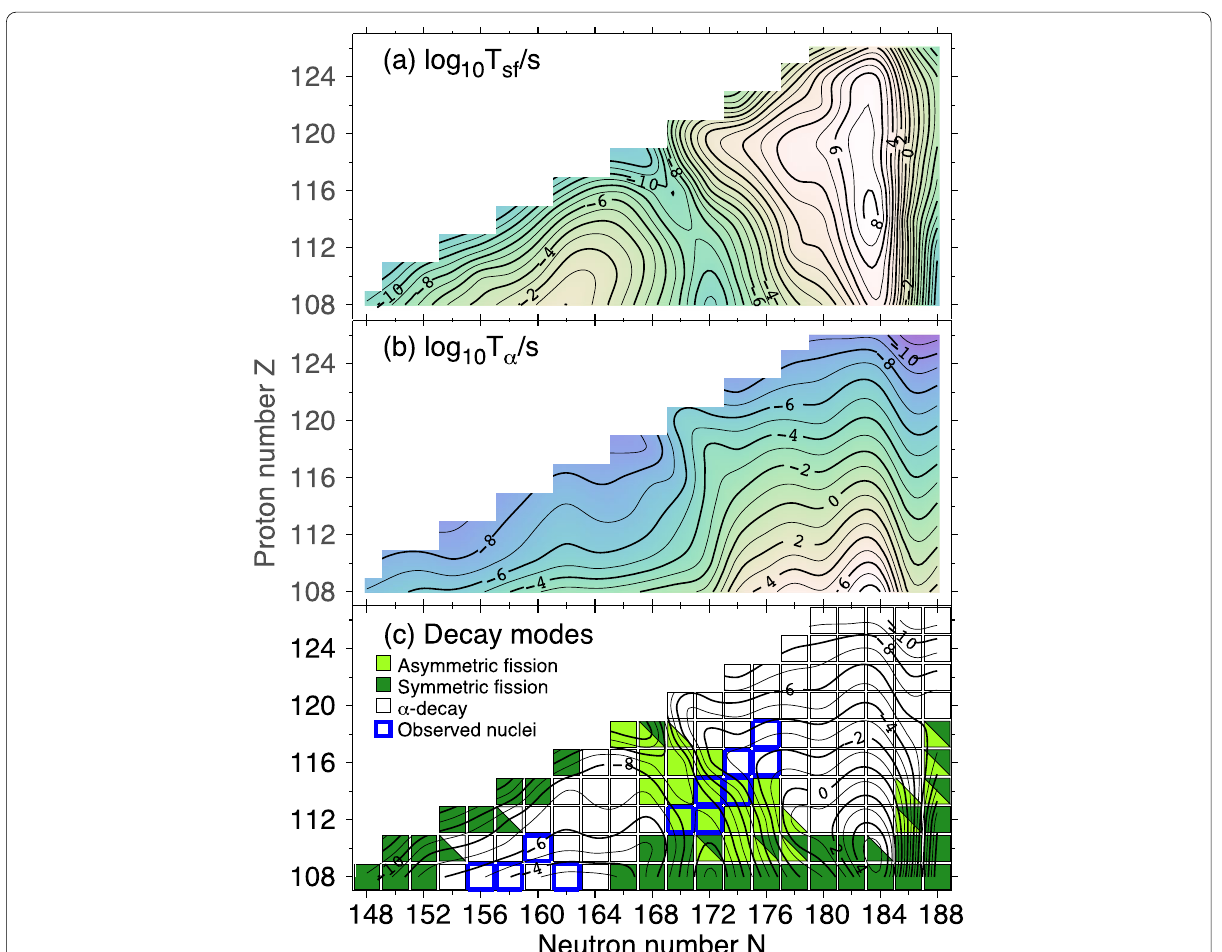
Fig. 9 a Inner fission barrier heights (in MeV). b SF half-lives log 10 T SF (in seconds). c α-decay half-lives log 10 T α (in seconds). d Dominant decay modes. If two modes compete, this is marked by coexisting triangles. The figure is adapted from